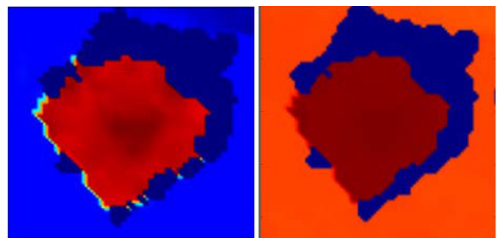
Figure 3. Left: the original voids around a building (in dark blue), right: the void after morphological closing